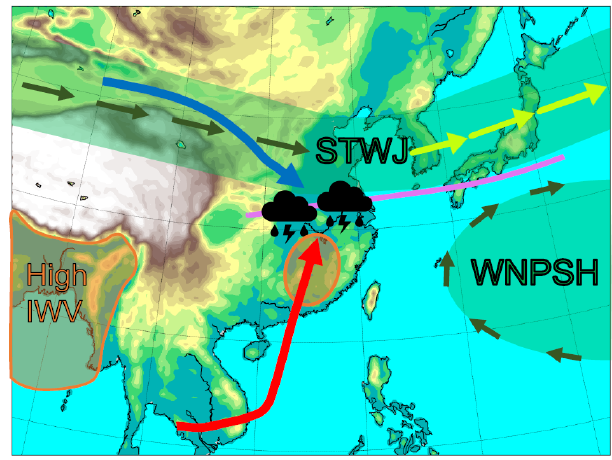
Figure 18. Schematic representation of the key factors of EASM progression during the Mei Yu stage. The cool (blue) and warm (red) low-level airstreams converge at the EASMF (magenta). Heavy precipitation thus occurs over central and eastern China, where high-moisture-content air is observed, up to values similar to those typical of the South Asian monsoon (orange). Regional flow features (green) control the balance of the air mass advection to- wards the EASMF, via the pattern and strength of the STWJ (jet streak in yellow) and the location of the